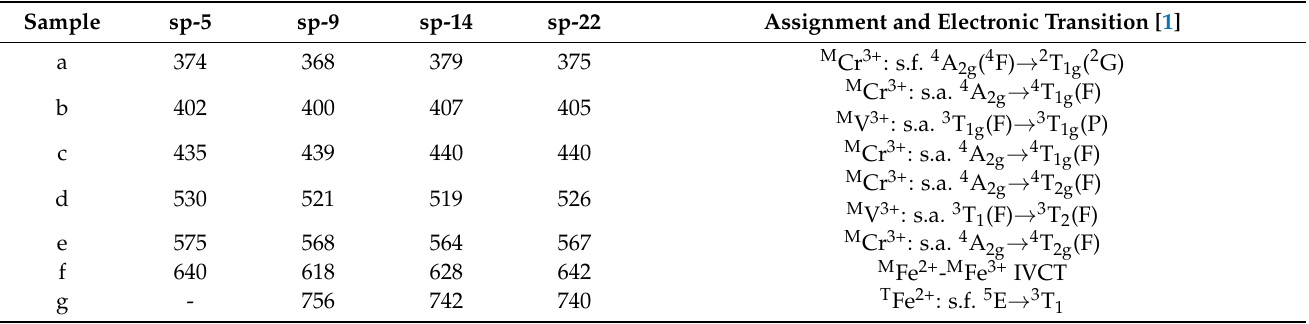
Table 5. Chromium–vanadium-bearing spinel UV-vis absorption spectrum assignment and electronic transition